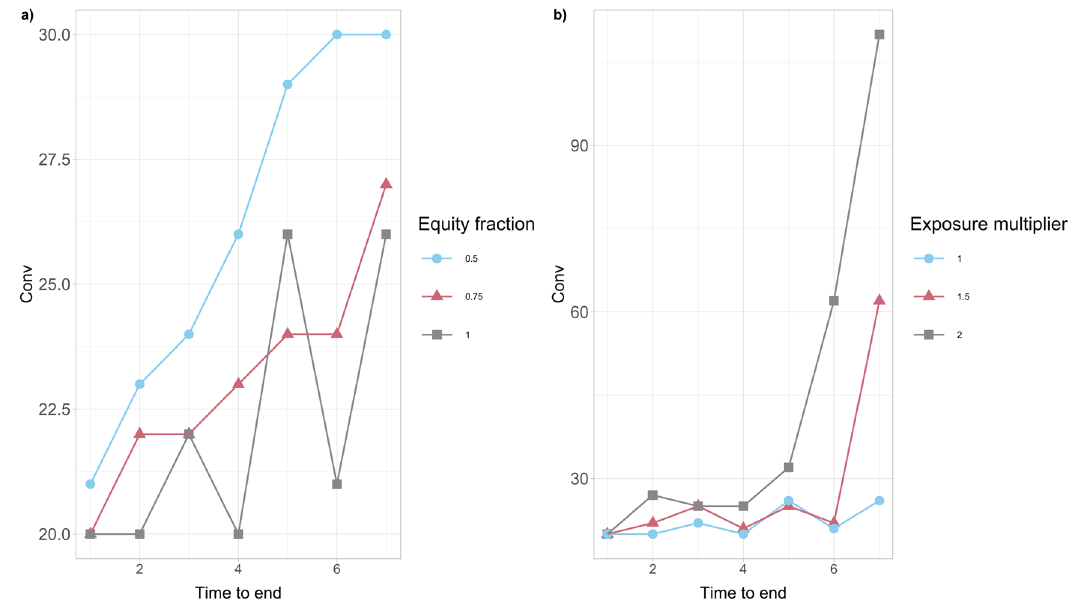
Fig.6|TheconveniencetointerveneConvfortheEuropeanBankingAuthority (EBA) network as a function of the time until the end of crisis. The values of Conv (in millions of EUR) are obtained for the percentage α =0.005 of wealth loss upon default. a We consider different percentages (50%, 75%, 100%) of the initial capital E i (0)availableto fi nancial institutions i attime0.Conv tends to increase on